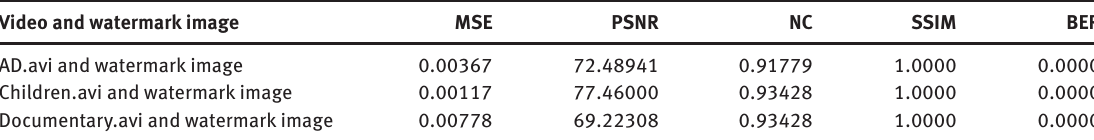
Table 14: Performance Analysis of System Using Different Parameters (LL